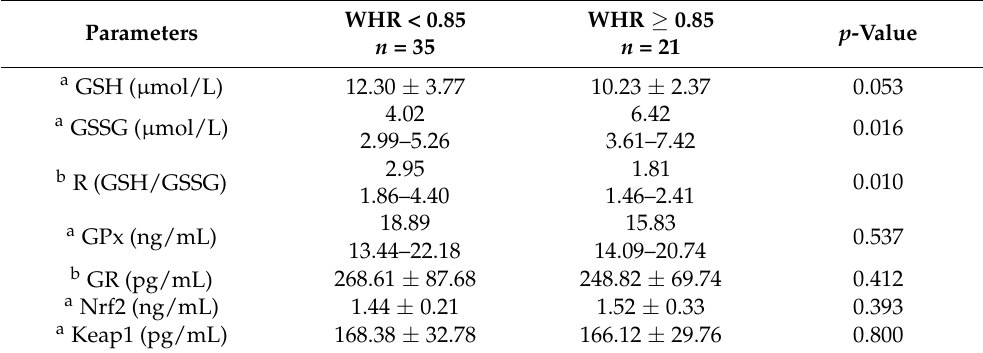
Table 4. Antioxidant defense parameters in women with PCOS divided according to the waist-to-hip ratio